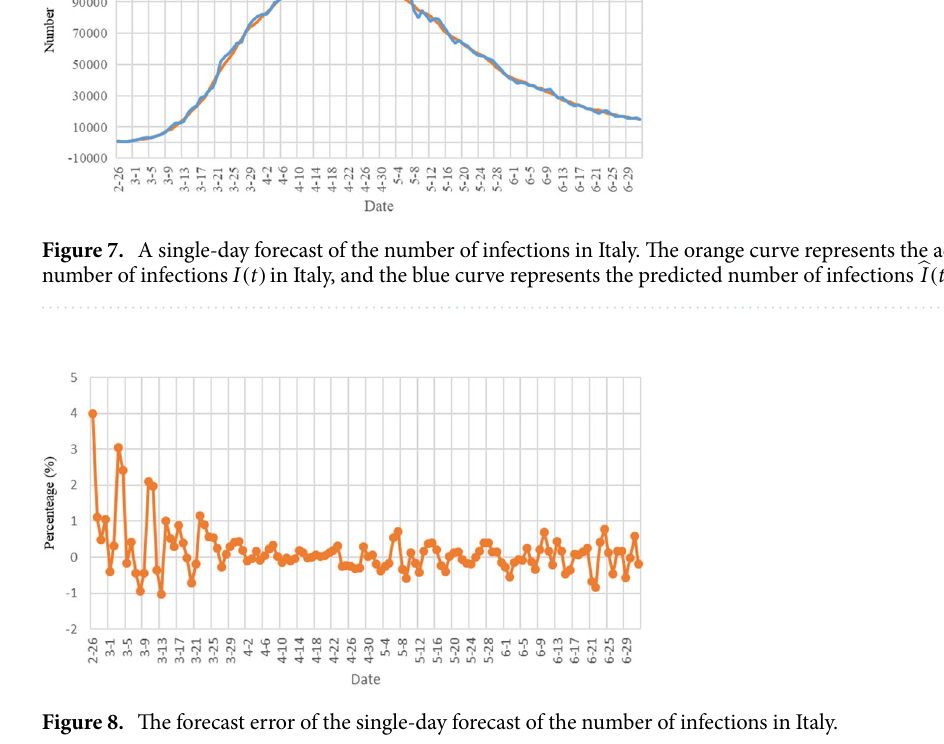
Figure 8. The forecast error of the single-day forecast of the number of infections in RQ3 experiment results. From September 2020 into the autumn and winter season, many countries have a sec- ond wave of COVID-19 infections. We applied the TW-SIR model to the data from August to October 2020 for seven countries in the data set, and the measurement results are shown in the Table 6. In South Korea and Brazil, the R 0 value was less than 1, indicating a downward trend in the number of infec- tions from September to October. For the exponential growth rate, only China and South Korea’s exponential growth rate is less than 0, and the average number of infected persons I ( t ) in these two countries is very small, which means that the development trend of the epidemic in these two countries is in a relatively stable state for a long time. Italy, Spain, Germany and Brazil have all seen a second wave of attacks, and the number of cases is rising. In Italy, for example, Fig. 9 shows the trend change in the number of existing infections after the TW-SIR model was applied. The orange line is the actual number of infections, and the blue line is the predicted change in the number of infections. As can be seen from the figure, the number of existing infections showed a slow decline from July to early August 2020. The average value of R 0 obtained by using the TW-SIR model during